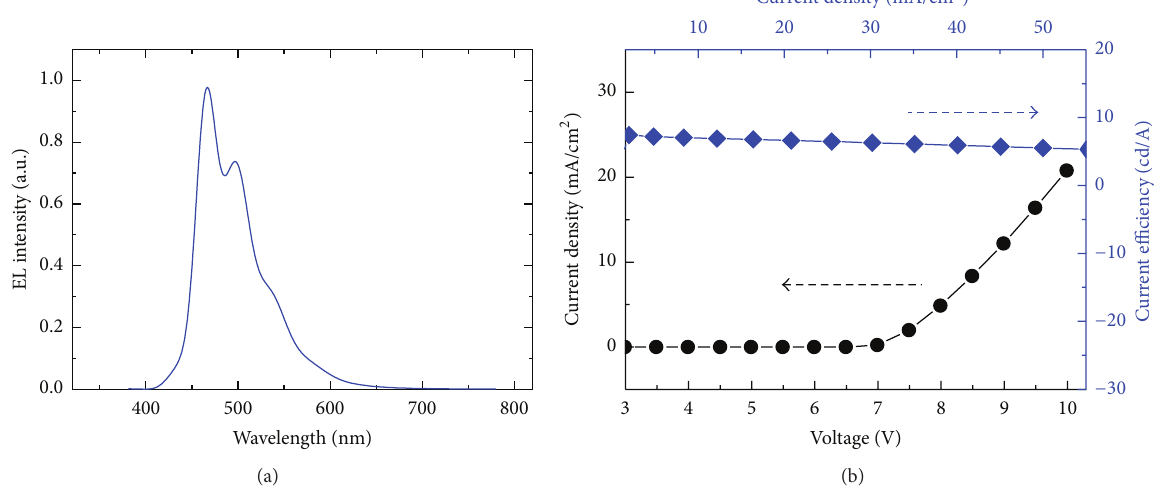
Figure 4: (a) EL spectrum of the OLED device. (b) J - V characteristic and current efficiency versus current density of the OLED device.